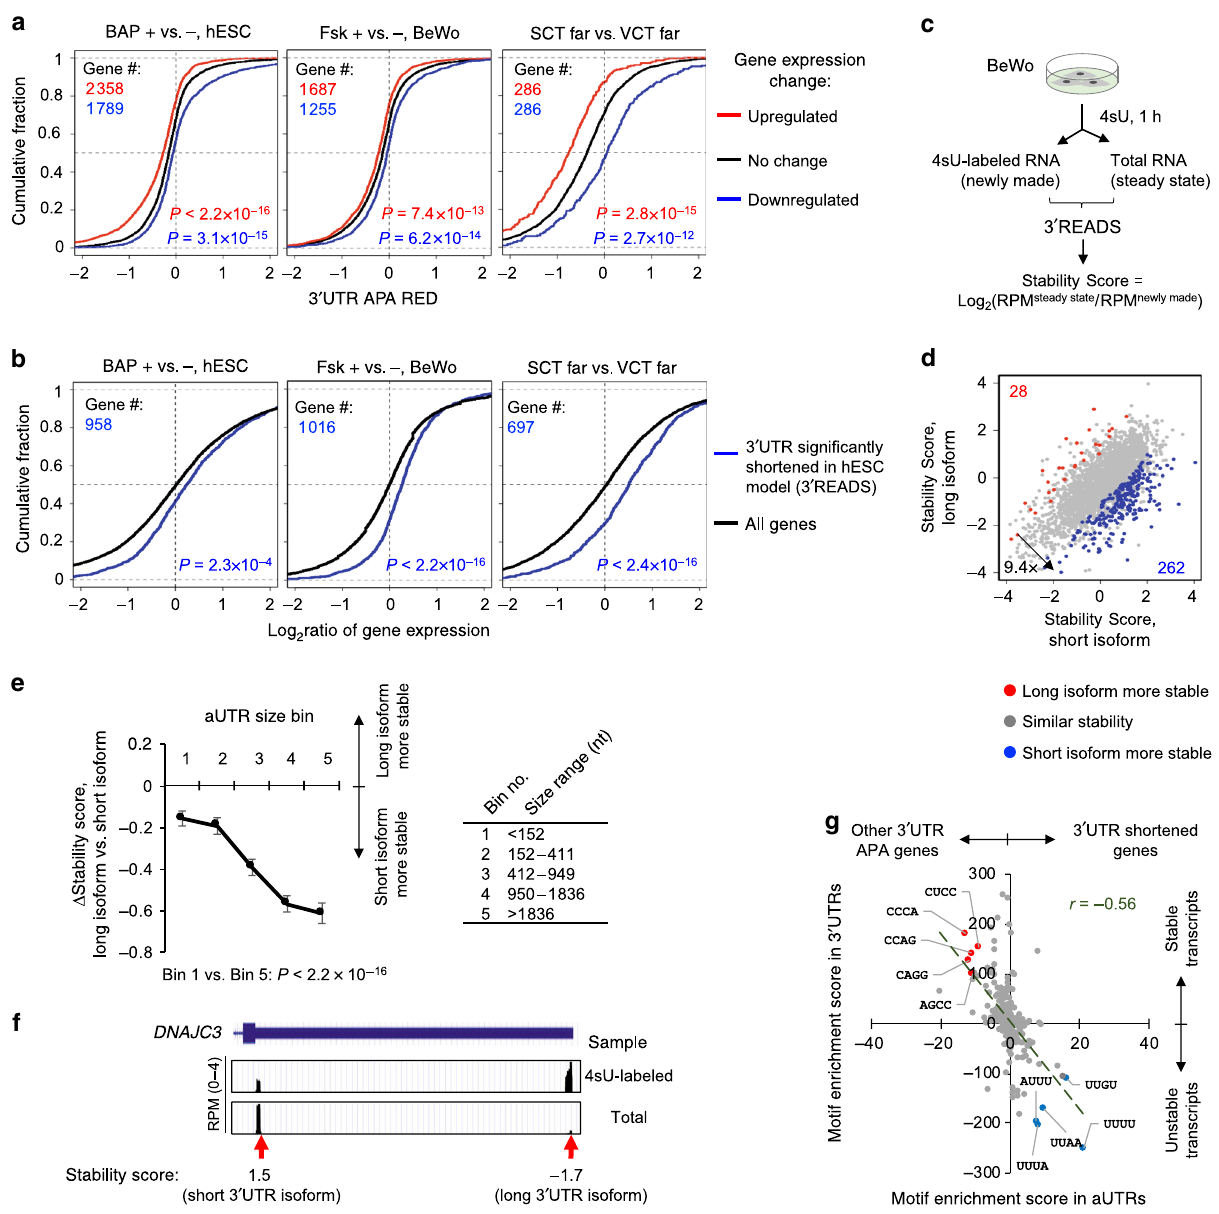
Fig. 6 3 ʹ UTR shortening is associated with increased mRNA abundance. a CDF curves of 3 ʹ UTR APA REDs for upregulated (red line), downregulated (blue line), and no change (black line) genes. Left, hESC model (>70 μ m); middle, BeWo model (day 3); right, SCT far cells vs. VCT far cells (Vento-Tormo et al. and Tsang et al. data combined). Number of genes in each gene set is indicated. Regulated genes for the hESC and BeWo models are those with fold change > 1.2 and P -value < 0.05 (DESeq), and regulated genes in SCT far cells vs. VCT far cells are top and bottom 10% genes based on fold change. P -values (K – S test) for signi fi cance of difference between red or blue genes and black genes are indicated. b CDF curves of gene expression changes for genes showing 3 ʹ UTR shortening in the 3 ʹ READS data (Fig. 2c, blue line) and all genes (black line) in three datasets (same as in a ). P -values are based on the K – S test comparing blue and black genes. c Schematic of mRNA stability analysis of BeWo cells. mRNA stability of each transcript is represented by a Stability Score, as indicated. d Scatter plot comparing Stability Score of short 3 ʹ UTR isoform ( x -axis) with that of long 3 ʹ UTR isoform ( y -axis). Genes whose isoforms have signi fi cantly different Stability Scores ( P < 0.05, DEXSeq) are highlighted in color. e Relationship between aUTR size and Stability Score difference between long and short isoforms. Genes are grouped into fi ve similarly sized bins (about 550 genes each) based on their aUTR length. P -value (Wilcoxon test) comparing Bins 1 and 5 is indicated. Data are presented as median value ± SEM. f UCSC Genome Browser tracks showing 3 ʹ READS data for DNAJC3 in total and 4sU-labeled RNA samples. g Tetramer enrichment scores for aUTRs of genes with shortened 3 ʹ UTRs (Fig. 2c) vs. aUTRs of other genes ( x -axis) are compared to enrichment scores for 3 ʹ UTRs of stable vs. unstable transcripts ( y Perturbation of cell secretion further con fi rms SCAP . We next pituitary tumor cell line AtT-20 45 . OEs of these factors indivi- dually or jointly led to enhancement of secretory capacity to could lead to 3 ʹ UTR size changes. To this end, we analyzed an various degrees 45 . As expected, Creb3l2 OE, which was reported RNA-seq dataset involving overexpression (OE) of active forms of to control expression of translation factors 45 , had only a modest impact on USPS gene expression (median log 2 Ratio = 0.03, XBP1 (spliced form) and Creb3l2 (cleaved form) in the mouse